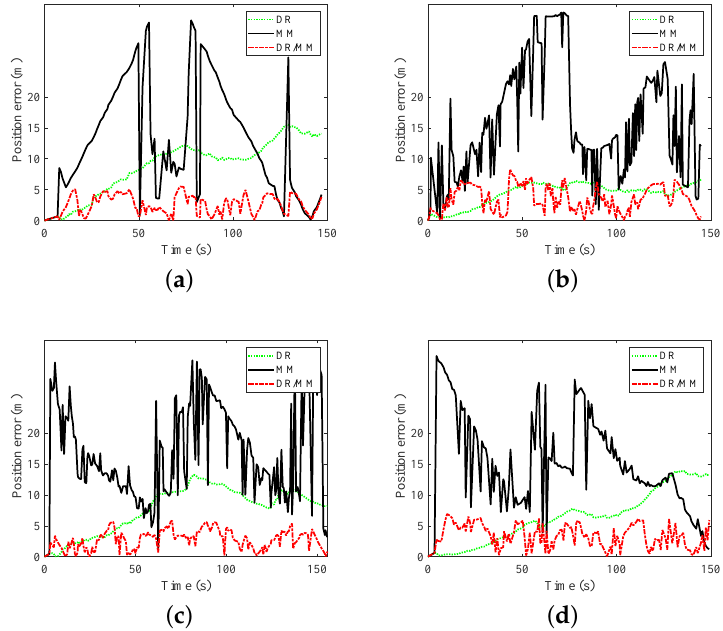
Figure 7. Position errors with different gestures in teaching building: ( a ) calling; ( b ) dangling; ( c ) handheld; and ( d ) pocket.